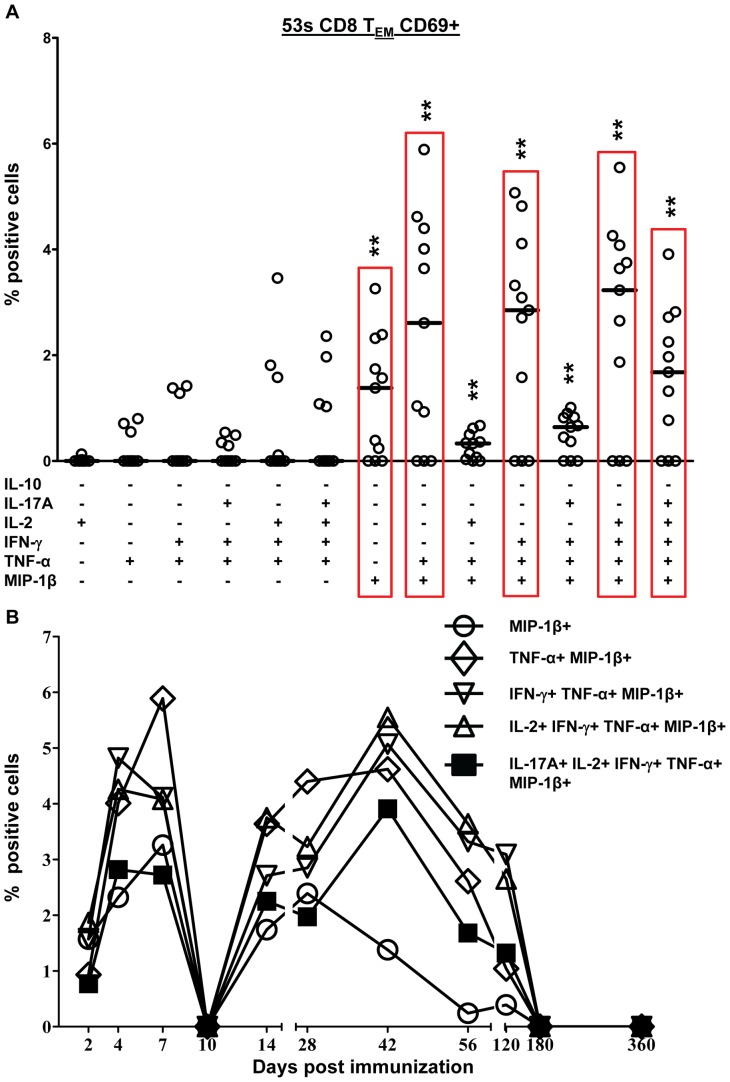
Multifunctional CD8+ TEM responses to S. Typhi-infected autologous B-LCL.A) Scatter plot showing all combinations of the 6 cytokines/chemokines measured that were positive at one or more time points for representative volunteer 53 s. Increases of >0.5% positive cells over uninfected targets were statistically significant (P<0.01). Each point represents a single time-point and the median value is denoted by a horizontal bar. The cyokine/chemokine combinations with the top 5 median values are indicated by red rectangles. Median values of the subsets of multifunctional cells that show a significant difference (**P<0.01), when compared to the subsets without asterisks, are indicated. B) Kinetics of the top 5 populations (as determined by median value) over time.